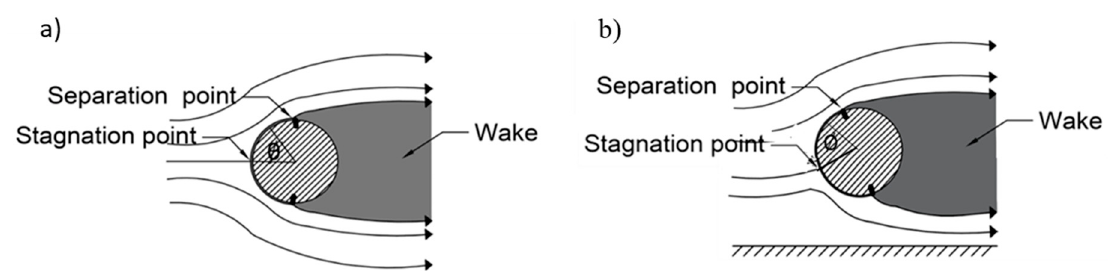
Figure 1. Schematic of the flow around a circular cylinder, showing stagnation and separation points: ( a ) free cylinder, and ( b ) cylinder near a plane boundary (adapted from Reference [3]). According to Sumer and Fredsøe [2], flow around a cylinder placed close to the bed as shown in Figure 1b may change as follows depending on the gap ratio e / D : The angular position of the stagnation point ∅ displaces and moves to lower